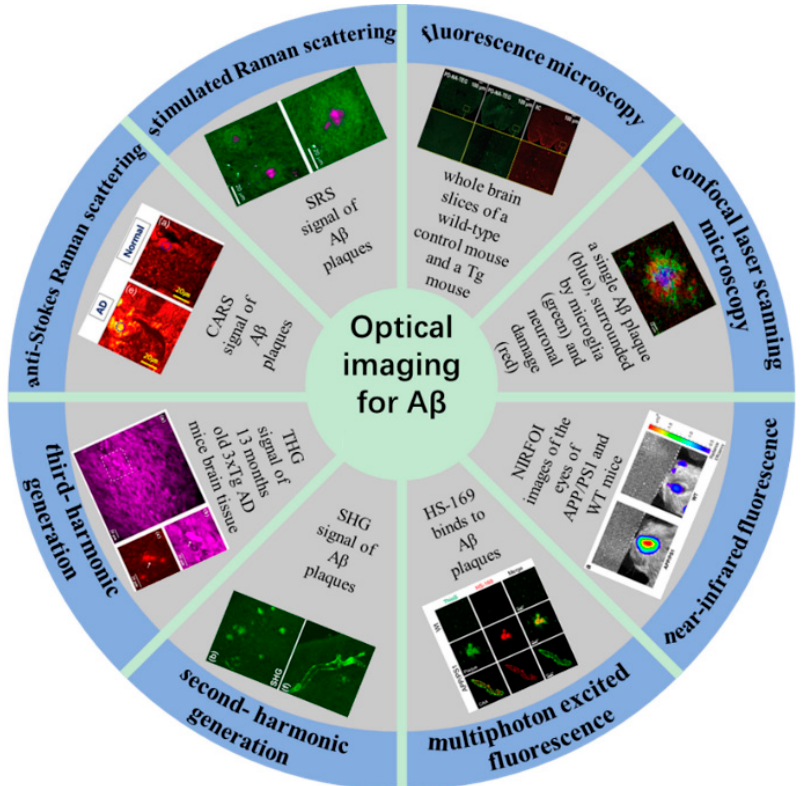
Figure 1. Optical imaging for A β plaque detection and visualization.